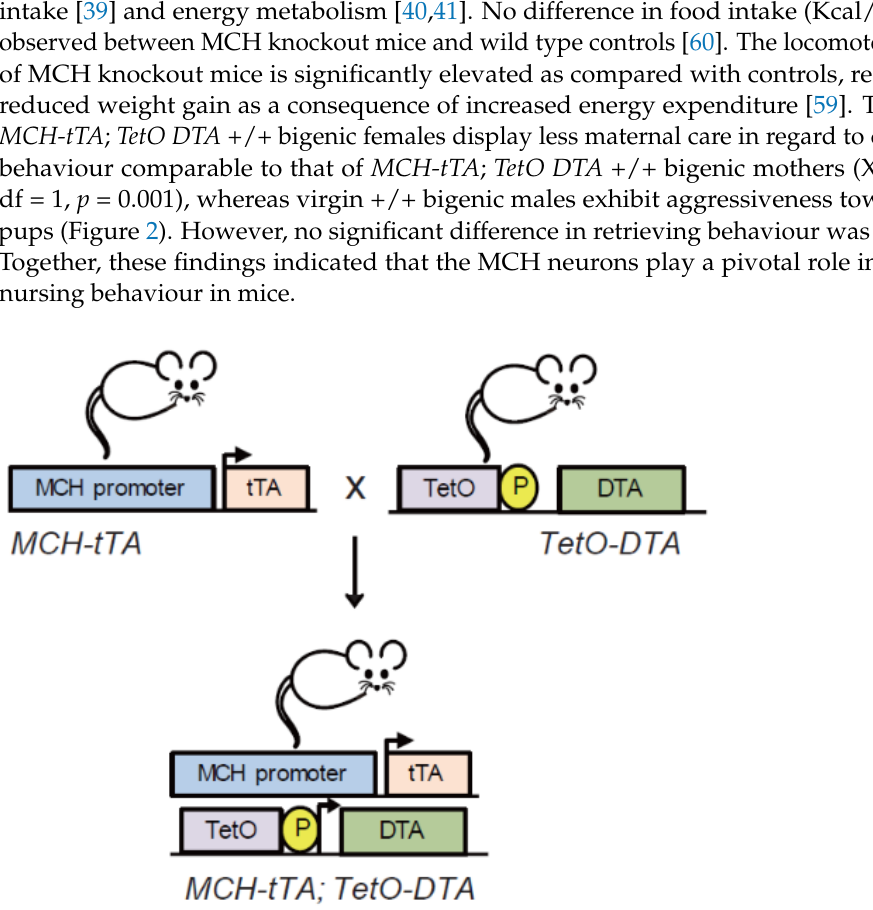
Figure 2. Cell-specific ablation of MCH neurons impairs nursing behaviour in both virgin female and male mice. Percentage of parental behaviour or attack pups of virgin MCH-tTA ; TetO DTA bi- genic. +/+ and +/ − female ( left ) and male ( right ) mice. The ratio of parental behaviour (crouching) in female mice was analysed by Chi-squared test; X-squared = 9.56, df = 1, p = 0.002 (From Kato et al. [59]).